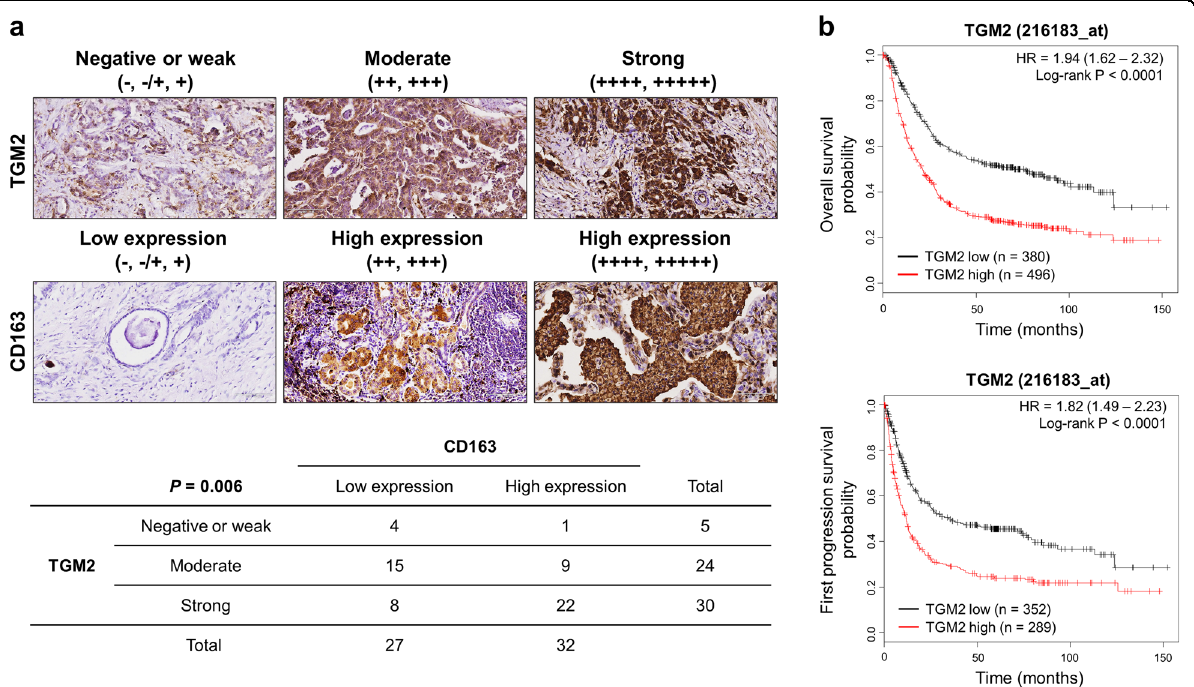
Fig. 6 Association between TGM2 expression and macrophage in fi ltration in gastric cancer (GC) tissue samples. a Immunohistological analysis of TGM2 and the macrophage marker CD163 expression in GC tissue specimens. The upper panel shows representative microscopy images for immunohistological analysis of samples classi fi ed by the immunoreactivity of TGM2 and CD163. The lower table summarizes the expression levels of TGM2 and CD163 in 59 GC tissue samples. b Effect of TGM2 mRNA expression on the overall and fi rst progression survival of GC patients. Kaplan – Meier plots were calculated for the overall (upper panel) and fi rst progression survival (lower panel) of GC patients with high TGM2 expression (red line) or low TGM2 expression (black line) using the online bioinformatic tool Kaplan – Meier Plotter